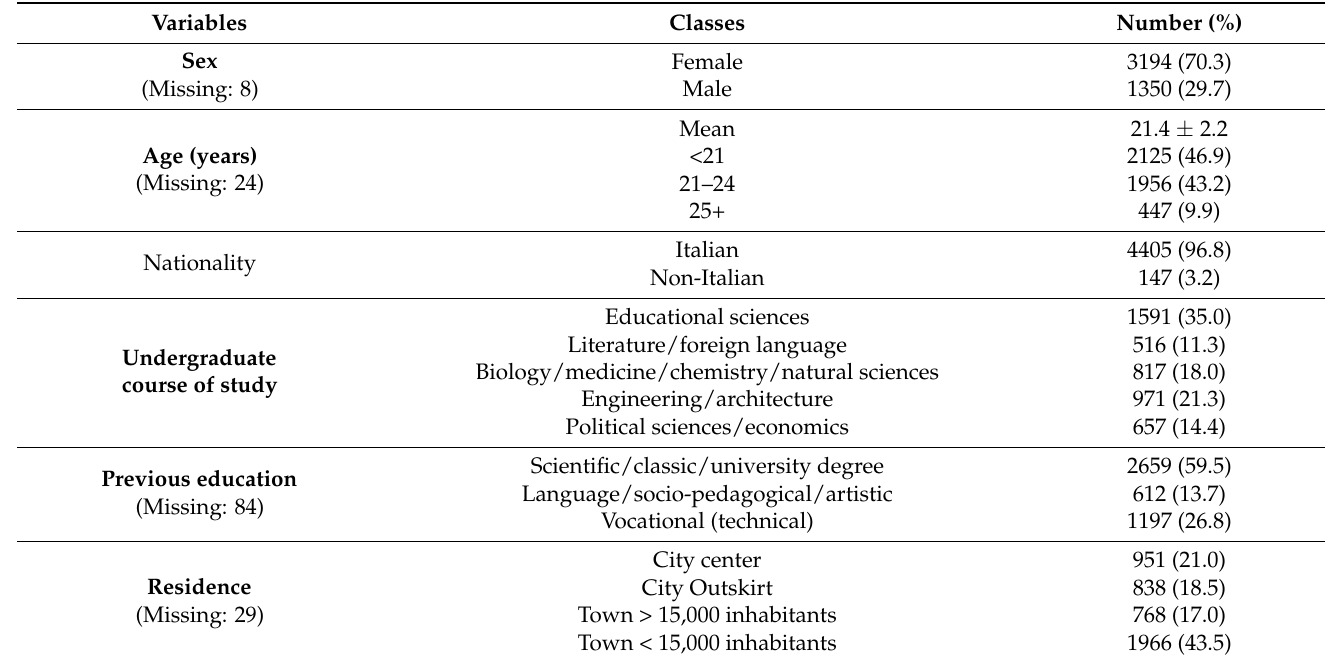
Table 1. Distribution of sociodemographic profile, educational level, and family background. Number and column percentage (%) or mean ± standard